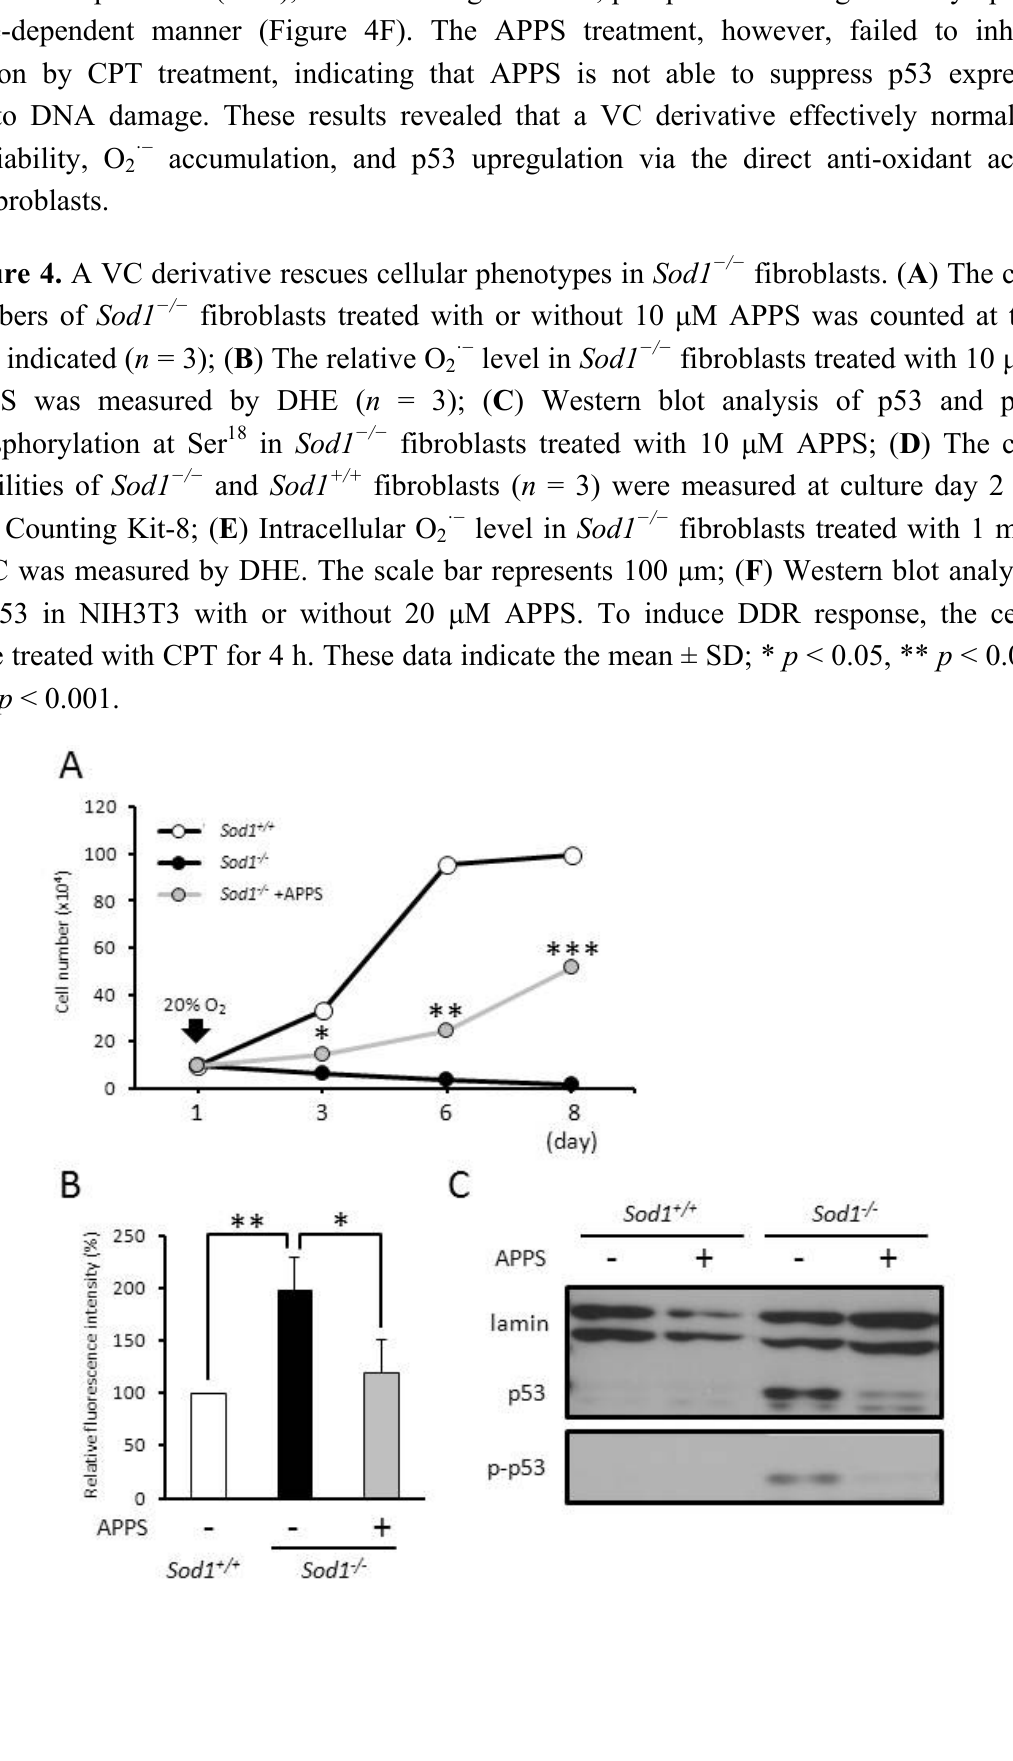
Figure 4. A VC derivative rescues cellular phenotypes in Sod1 − / − fibroblasts. ( A ) The